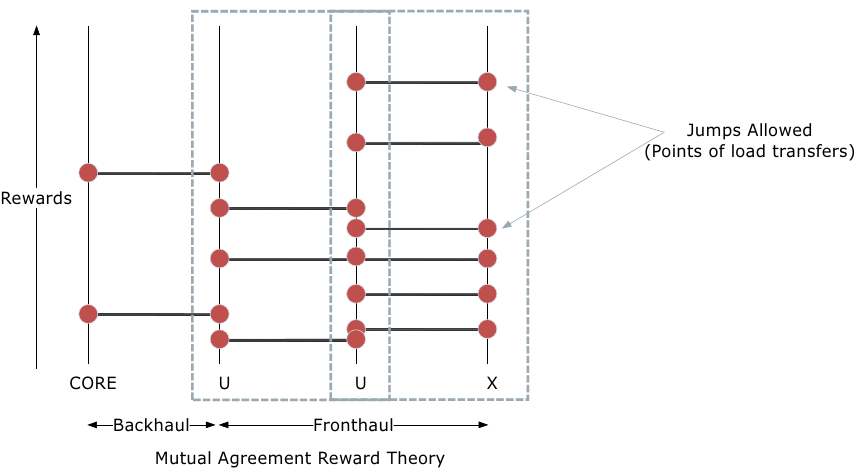
Figure 2. An exemplary illustration of reward-jump system used for mutual agreement between the entities to ensure smooth and low-overhead